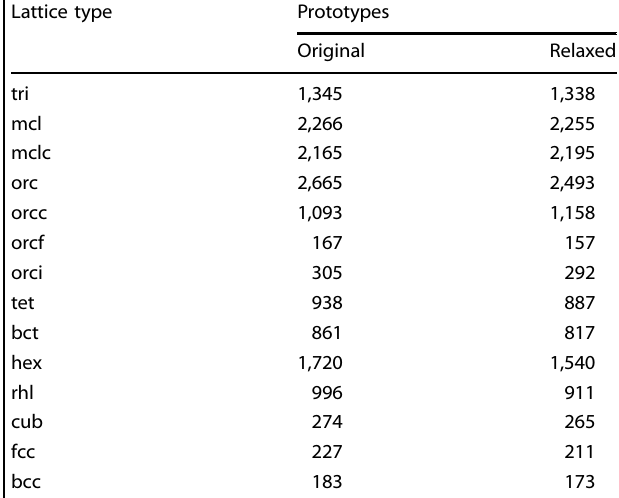
Table 4. The prototypes and their symmetries. The prototypes are grouped into the 14 Bravais lattices: triclinic (tri), monoclinic, (mcl), base-centered monoclinic (mclc), orthorhombic (orc), base-centered orthorhombic (orcc), face-centered orthorhombic (orcf), body- centered orthorhombic (orci), tetragonal (tet),